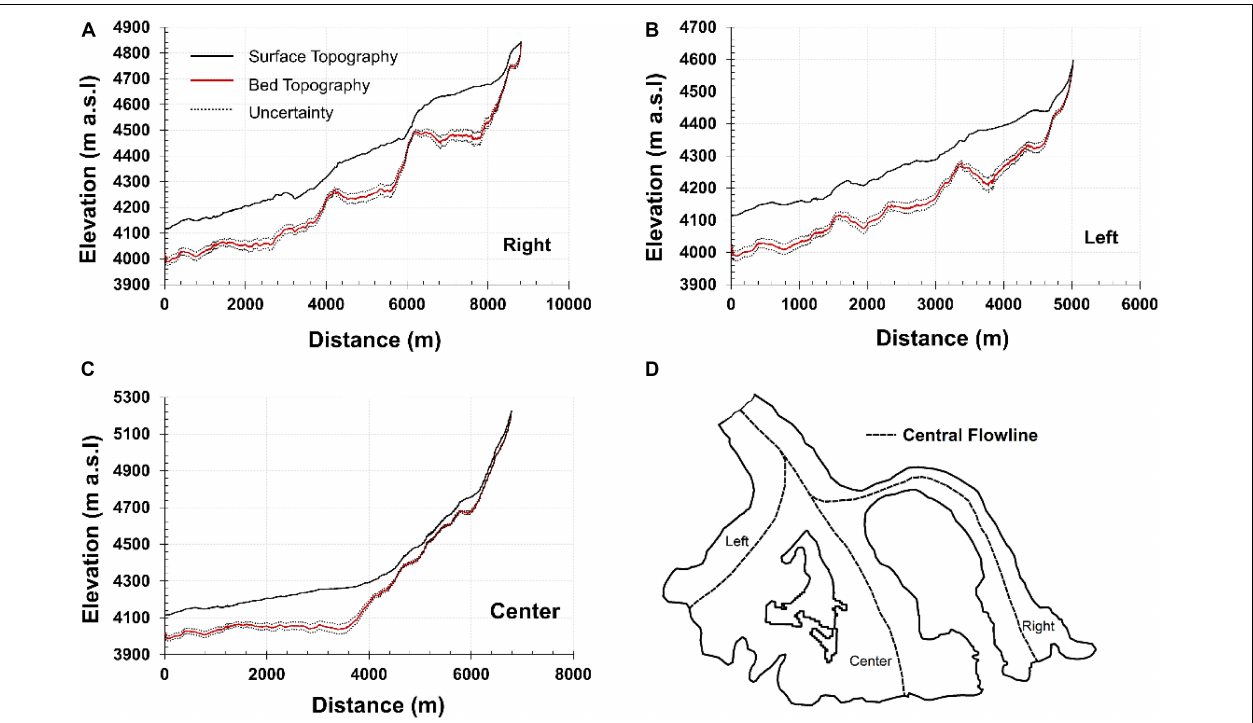
FIGURE 3 | Glacier surface and bed topographic profiles of the Gepang Gath Glacier along the central flowline of (A) right tributary, (B) left tributary, (C) the main trunk, and (D) glacier boundary demarcated with left and right trunk of the glacier. The location of confluence of all three parts of the glacier (i.e., A – C ) is between 4200 and 4300 m a.s.l.